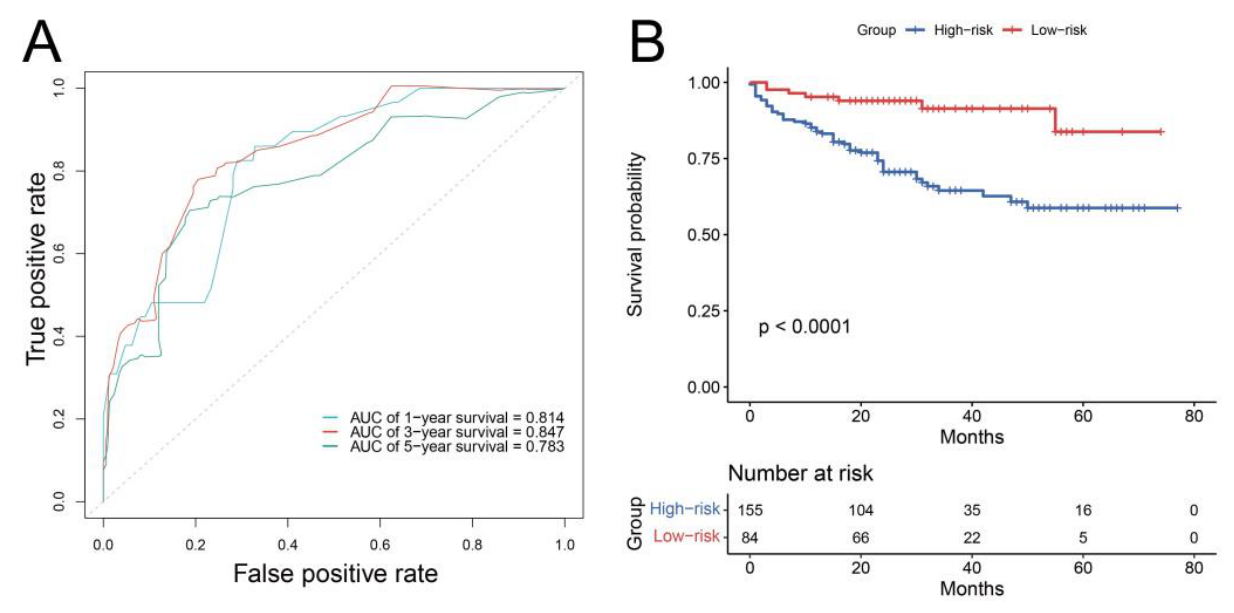
Figure 7. Receiver operating characteristic curve ( A ) and Kaplan – Meier curves of risk group ( B ) of the external validation cohort.